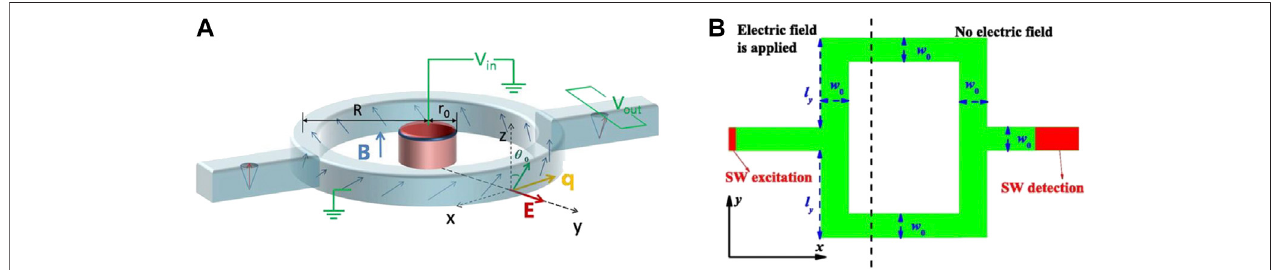
FIGURE 9 | (A) Schematic diagram of voltage-controlled spin-wave phase shifter based on spin-orbit coupling interaction (Liu and Vignale, 2011). Reproduced withthepermission fromhttps://journals.aps.org/prl/abstract/10.1103/PhysRevLett.106.247203. (B) Schematicdiagramofvoltage-controlledspin-wavephase shifter based on DMI (Wang et al., 2018b). Reprinted from Wang, X.-g., Chotorlishvili, L., Guo, G.-h., and Berakdar, J. (2018). Electric fi eld-controlled spin waveguide phase shifter in YIG. Journal of Applied Physics 124 (7), 073903. With the permission of AIP